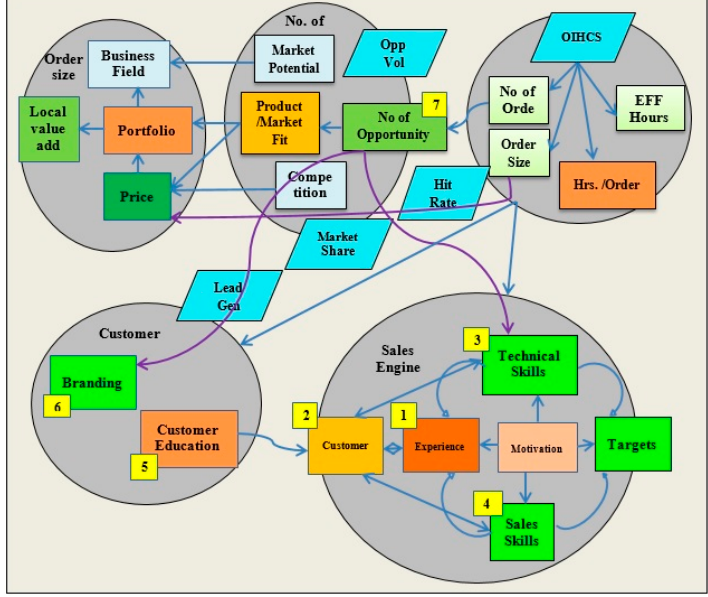
Figure 1. Complex decision problem by the analytical network process (ANP) method.